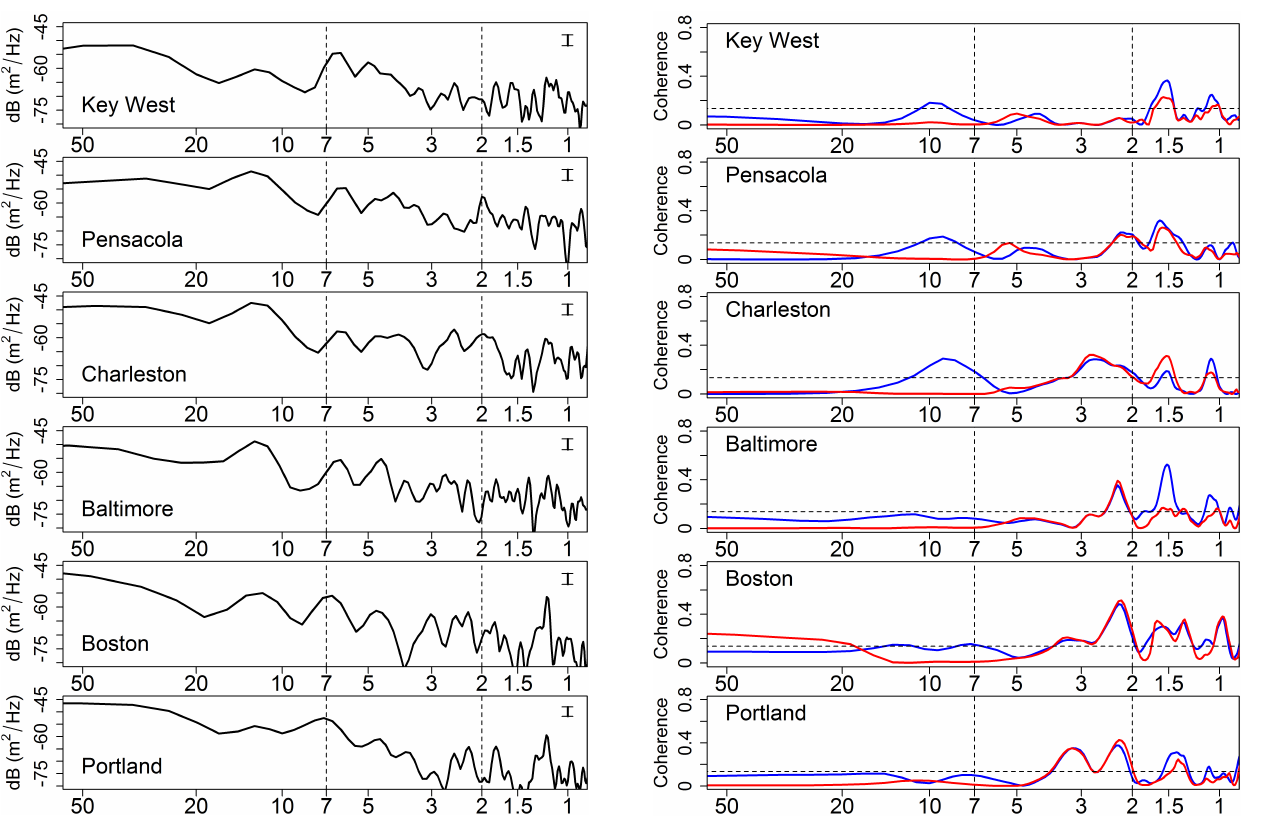
Fig. 8. Coherence between AMOI and interannual sea level vari- ations (blue), and coherence between the reconstruction from the AMOI(ENSO) and interannual sea level variations (red). The hori- zontal axis is the spectral period in years. Vertical dashed lines mark ENSO band frequencies, the horizontal dashed line quantifies the threshold to reject the null hypothesis of random coherence at the 95% confidence level (Thompson,